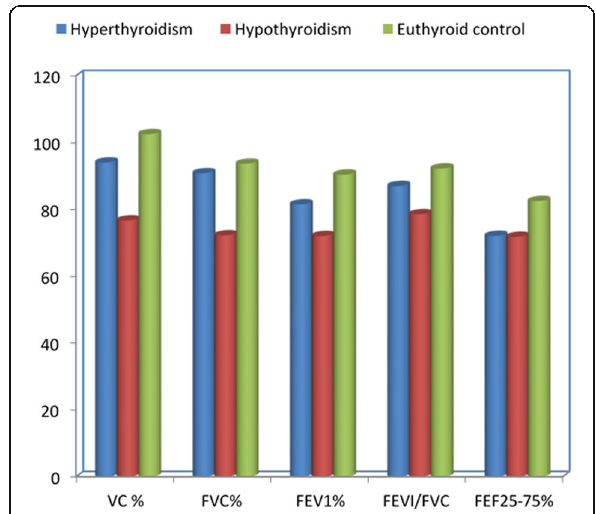
Fig. 2 Bar chart between groups according to pulmonary function